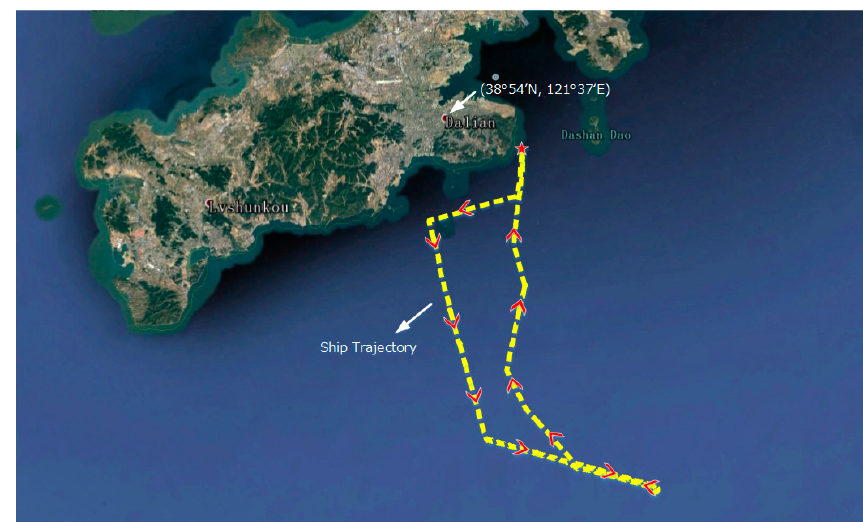
Figure 16. The ship trajectory of the ship-mounted experiment.